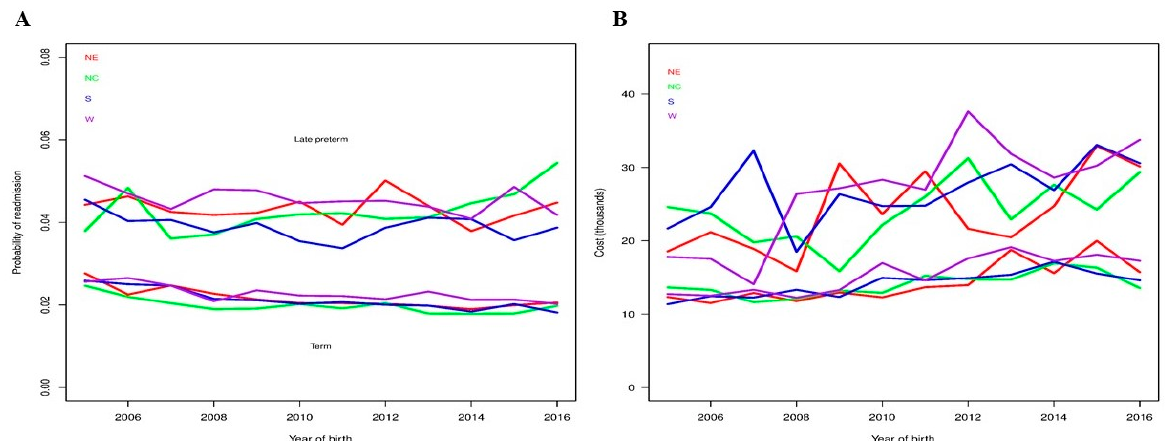
Figure 5. Readmission rates and costs for late preterm and term infants from 2005–2016. Panel ( A ) displays estimated probabilities of readmission for late preterm infants (LPIs) compared to term infants (TIs) by region based on fitted regression models. Panel ( B ) displays estimated mean costs by region from fitted regression models.